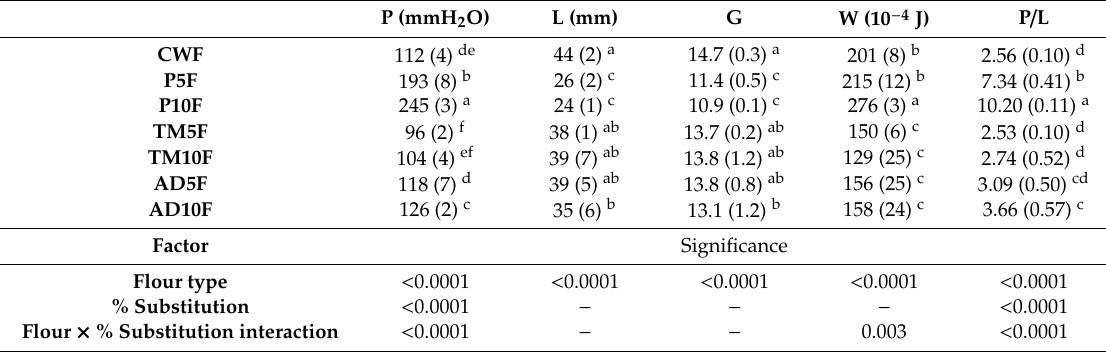
Table 1. Alveographic characterisation of the control wheat flour (CWF) and six blends of wheat flour and alternative protein sources used for bread